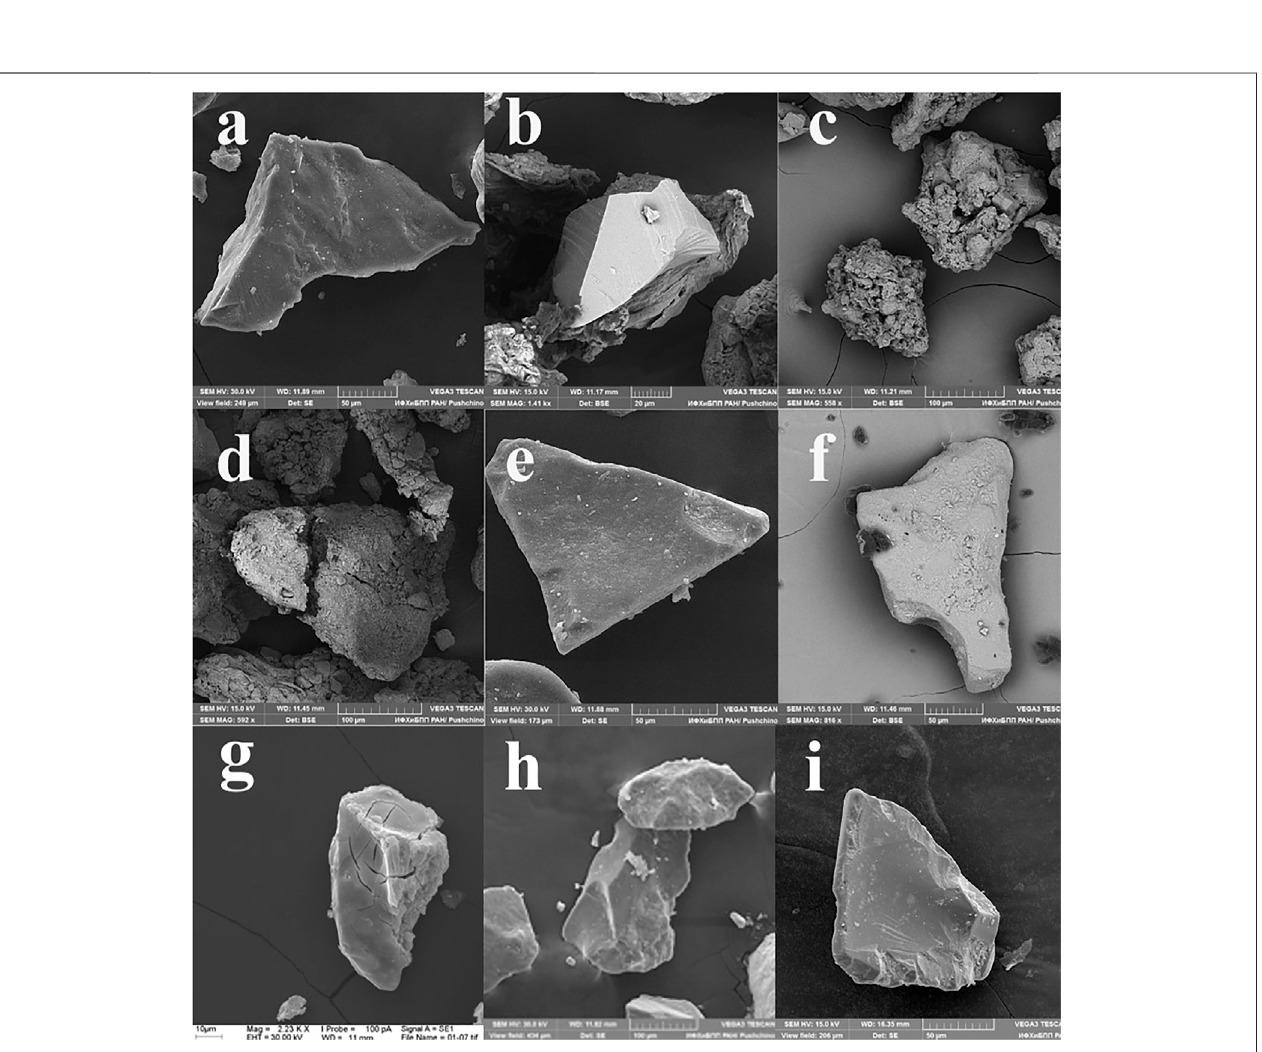
FIGURE 9 | Grain morphology images from a raster electron microscope on the Duvanny Yar sediments. (A) – fresh surface; (B) – sharp, coarse grain edge; (C) – cryogenic aggregate; (D) – obvious crack; (E) – fresh surface; (F) – nodular edge; (G) – radial fractures on quarts grain; (H) – fresh surface with nodular edge; (I) – fresh conchoidal surface with shell